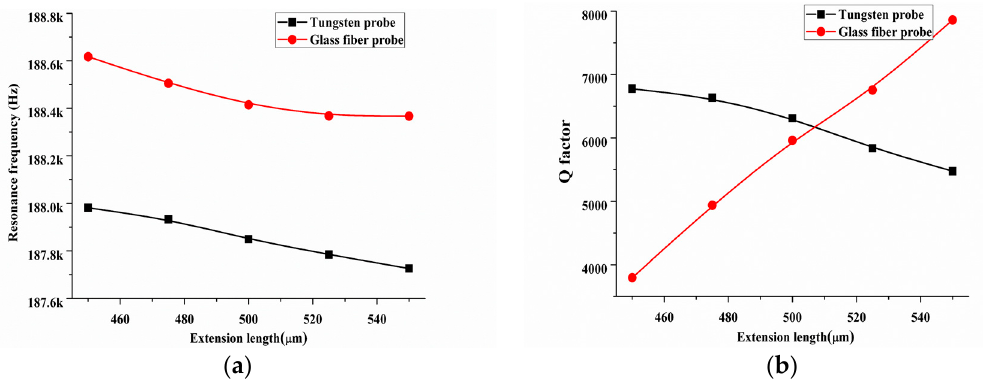
Figure 8. ( a ) Resonance frequency and ( b ) Q -factor changing with the increase of the extension length for tungsten and the glass fiber probes.